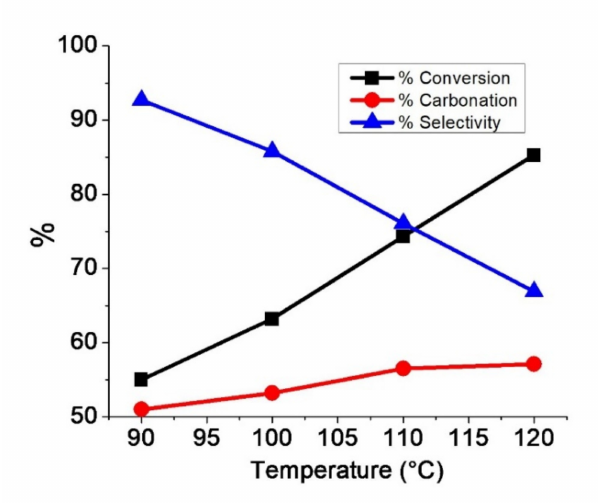
Figure 5. Effect of temperature on the conversion, carbonation, and selectivity degree.